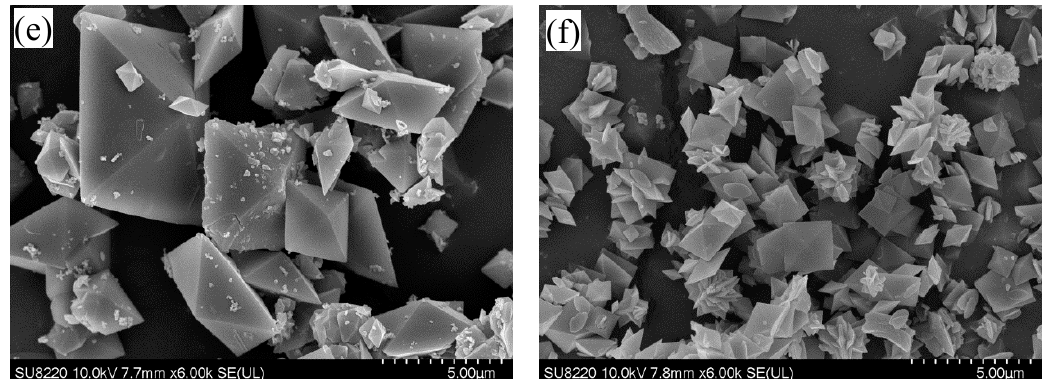
Figure 7. The polymorphic forms of calcium oxalate crystals obtained under various conditions using scanning electron microscopy (SEM): ( a ) monoclinic monohydrate (COM) without inhibitors; ( b ) COM in the presence of 1000 ppm magnesium; ( c ) COM in the presence of 800 ppm citrate; ( d ) triclinic trihydrate (COT) in the presence of 500 ppm hydroxycitrate; ( e ) tetragonal dipyramidal dihydrate (COD) in the presence of 1.5 ppm phytate; ( f ) COD in the presence of 20 ppm chondroitin sulfate.